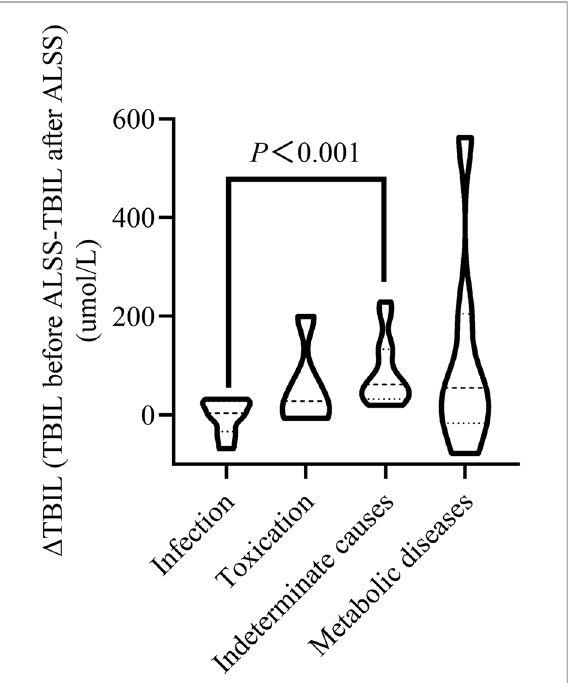
FIGURE 4 The change in the total bilirubin level after ALSS based on different